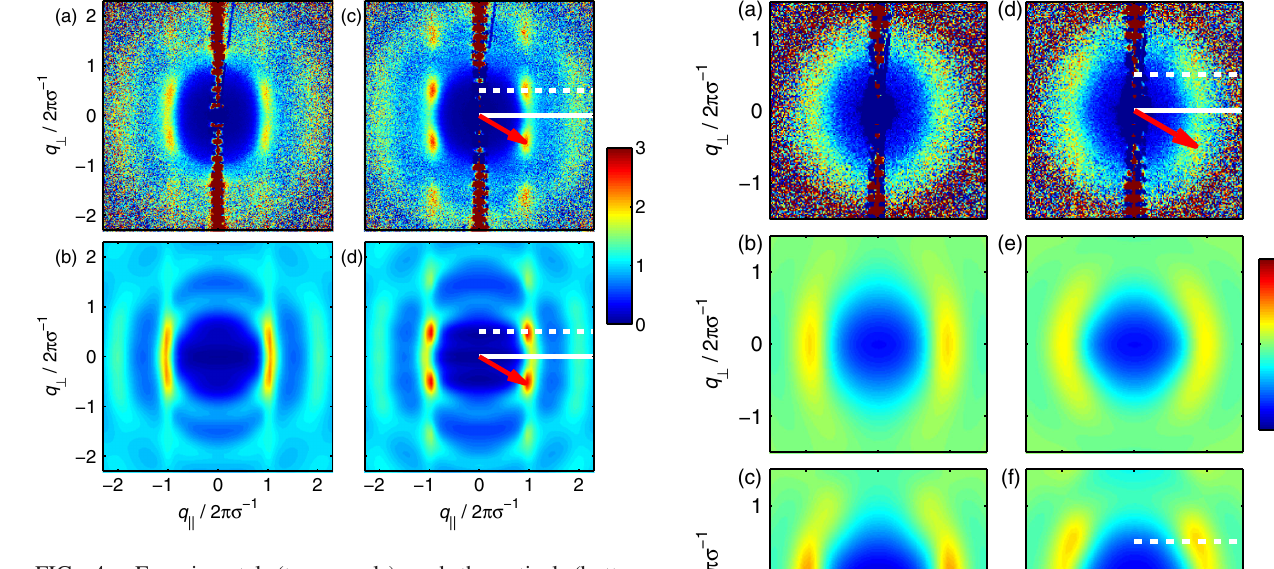
FIG. 4. Experimental (top panels) and theoretical (bottom panels) anisotropic structure factors S ð q Þ for a dense hard-sphere fluid confined between planar surfaces. Data are presented as a function of in-plane ( q ∥ ) and out-of-plane ( q ⊥ ) scattering vector components. The surface separations are (a,b) H ¼ 2 . 45 σ and (c,d) 3 . 10 σ , and the confined fluid is kept in equilibrium with a ¼ 0 . 75 σ − 3 . The theoretical data bulk fluid of number density n b have been obtained assuming hard confining walls ( βϵ ¼ 0 ). The dark red feature at q ∥ ¼ 0 in the experimental data, which is due FIG. 5. As in Fig. 4, except for a moderately dense hard-sphere ¼ 0 . 38 σ − 3 ). The surface separations are (a) – (c) H ¼ to diffraction from the colloid-filled nanofluidic channel array, fluid ( n b 1 . 7 σ and (d) – (f) 2 . 0 σ , and the theoretical data in the middle and should be neglected in the comparison. The solid and dashed white lines illustrate in-plane cuts of S ð q Þ for q ⊥ ¼ 0 and 1 = 2 , bottom panels have been obtained using hard ( βϵ ¼ 0 ) and respectively, as displayed in Fig. 7, while the red arrows depict slightly sticky hard surfaces ( βϵ ¼ 1 . 1 ), respectively. Note that the scattering vector q of the primary peaks in the structure the q ∥ and q ⊥ scales and the color coding differ from those in max factor, as utilized in Fig. 6. Fig.